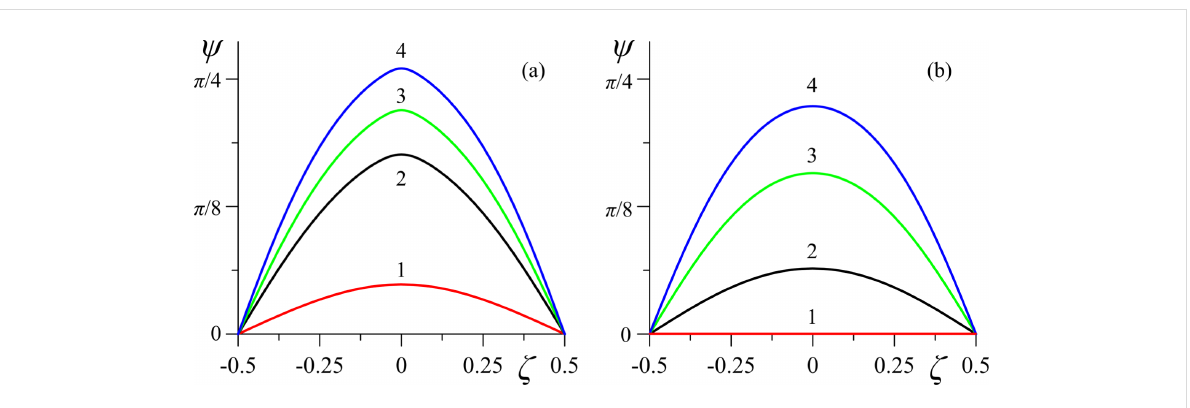
Figure 4: Spatial distributions of the orientation angle φ ( ζ ) of the NLC director n for different values of the magnetic field strength h in the case of (a) strong ( κ = 0.01) and (b) weak ( κ = 0.5) segregation of impurity CNTs: curve 1 – h = 2.75; curve 2 – h=2.85 ; curve 3 – h = 3.0; curve 4 – h = 3.2.